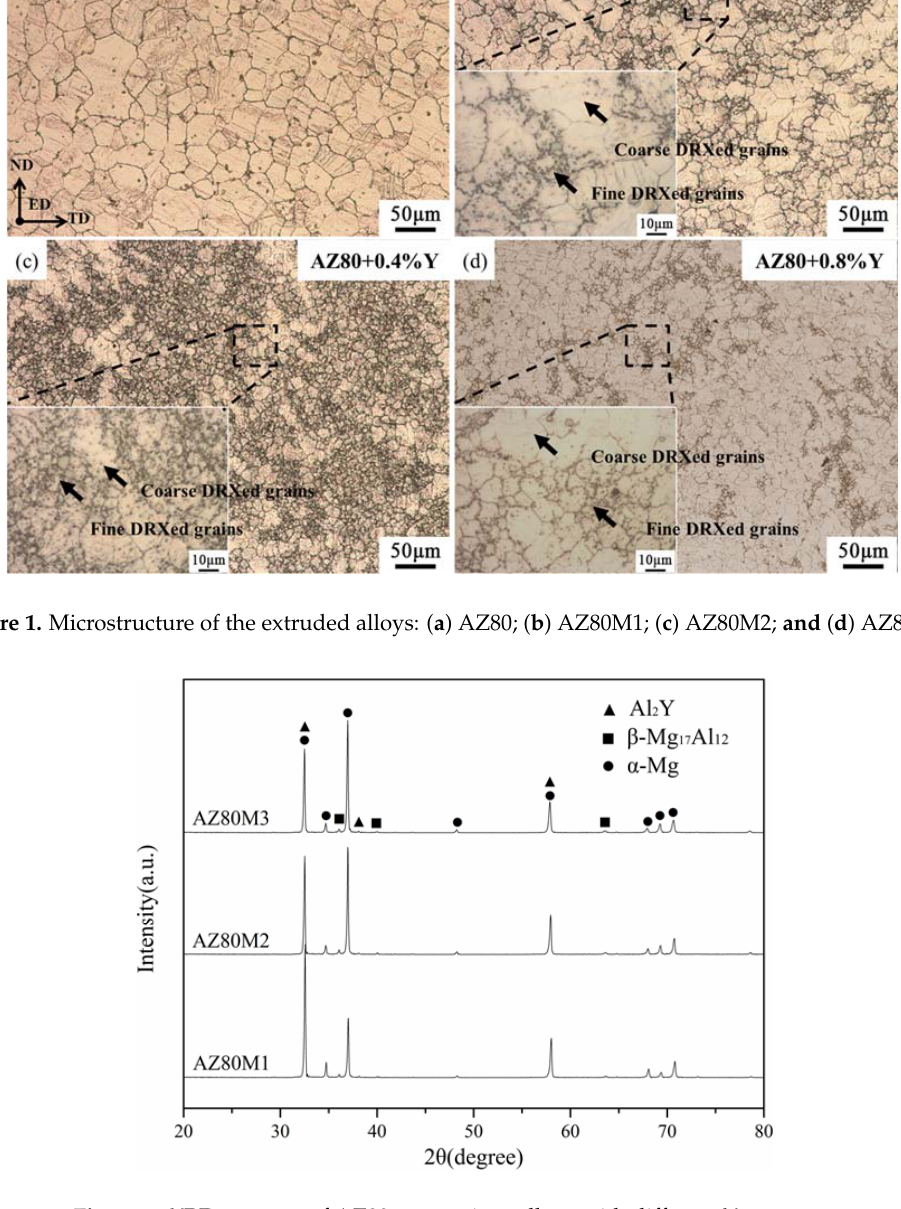
Figure 2. XRD patterns of AZ80 magnesium alloys with different Y contents.